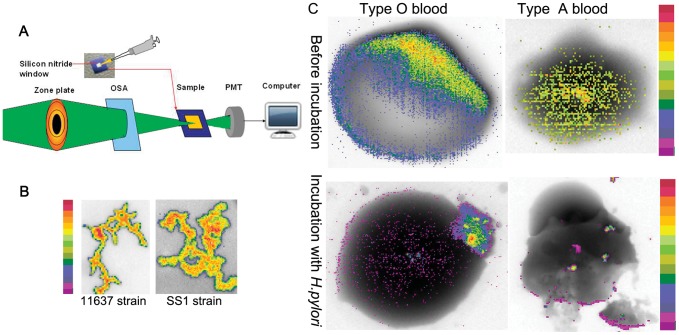
Observation of erythrocyte and H. pylori NCTC11637 strain by synchrotron radiation soft X-ray spectromicroscopy.(A) Schematic layout of the BL08U beamline. OSA is the order-sorting-aperture. PMT is photomultiplier tube. (B) Dual-energy (707.8 eV and 704 eV) contrast images of H. pylori and iron element. Colored bar on the left side indicates the iron content. From bottom to top, the gradient colors indicate increased iron content. The NCTC11637 strain is shown on the left and the SS1 strain is shown on the right. Two strains appear orange-yellow or light yellow, which means that these H. pylori contained more iron than nearby erythrocytes. (C) Dual-energy (707.8 eV and 704 eV) contrast images of erythrocytes with the iron element. Colored bars on the right side indicate iron content. Type O erythrocyte is on the left and type A erythrocyte is on the right. The color bar represents relative content changes. It has 16 different colors from bottom to top, which correspond the iron element content. For instance, the purple represents lower iron content, and the orange represents higher iron content. From Figure 3C we noticed, before incubation with H. pylori, the iron content is rather high (orange to yellow). However, after incubation with H. pylori, the iron content of erythrocyte is obvious low (purple). Part of the cell membrane of the type A erythrocyte in the right lower corner is damaged.